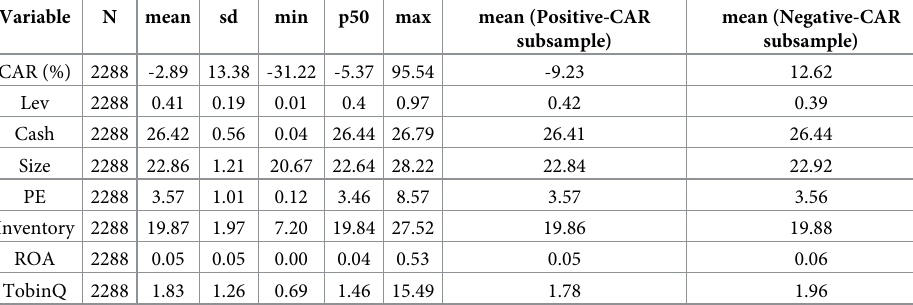
Table 5. Descriptive statistics of all